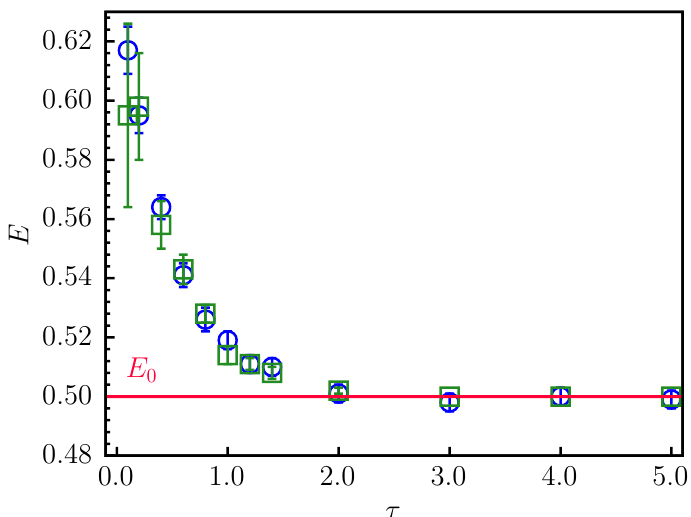
Figure 7: Evolution of the total energy to the ground state of the harmonic oscillator as a function of the imaginary time τ using the exact action. A single bead is enough for estimates using the mixed estimator, whose values are represented by squares. Results obtained through the thermodynamic estimator at the central bead of a three beads necklace are displayed by circles. The line shows the analytical value of the = 1 / ground state energy E 0